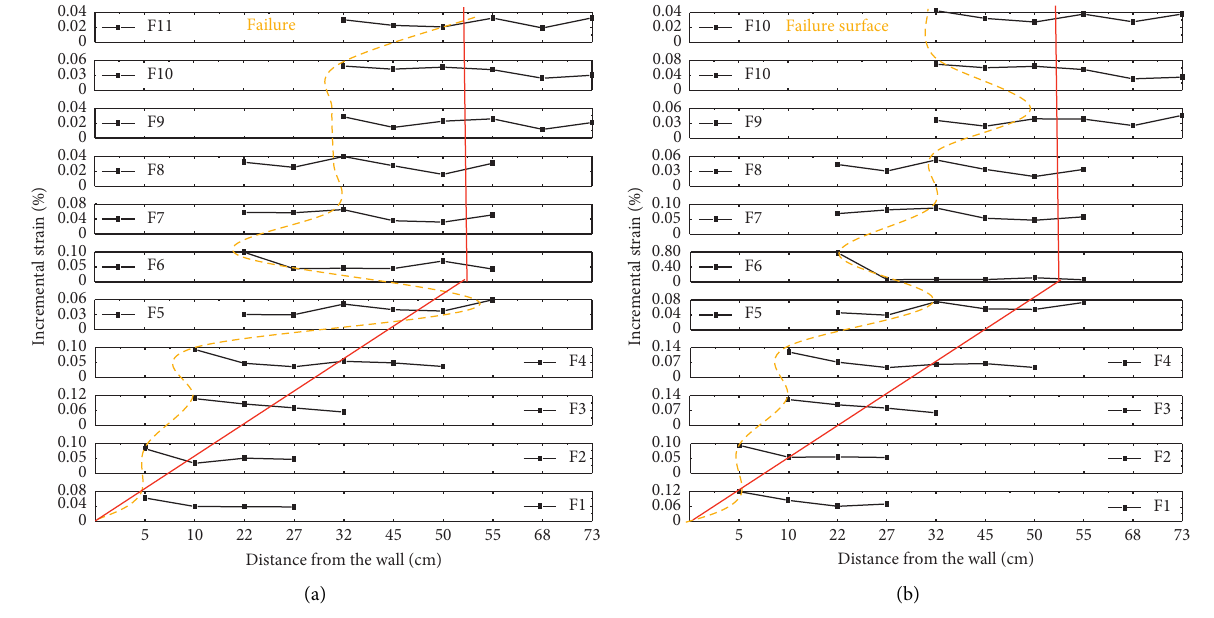
Figure 18: Distribution of strain in reinforcement layers for specimen 2. (a) Case 31. (b) Case